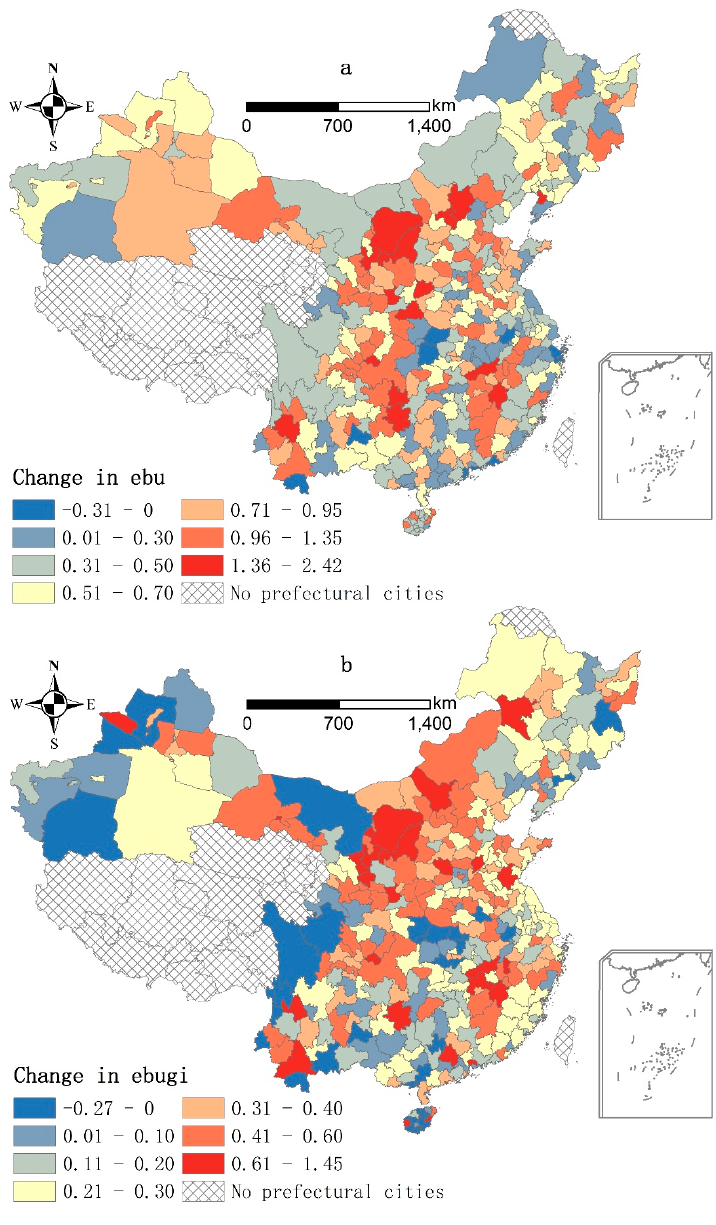
Figure 4. Cont. Figure 4.